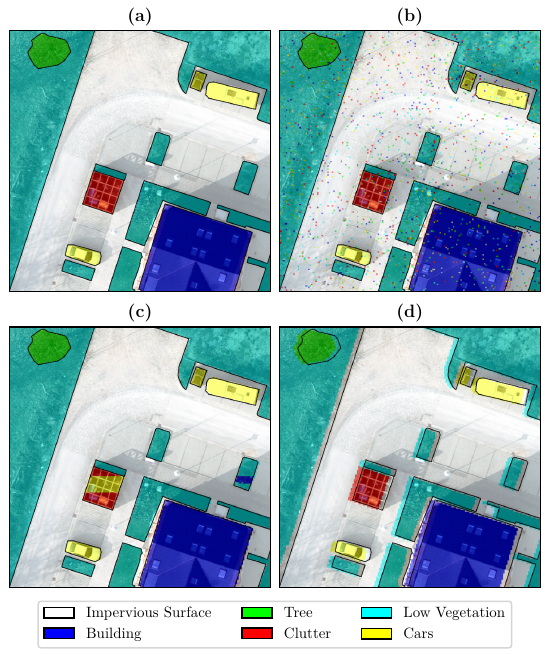
Figure 1. Labels before and after introducing different label noise. (a) original Label, (b) Label corrupted with random label (pixel) noise, (c) Label corrupted with segment error, (d) Label corrupted with segment